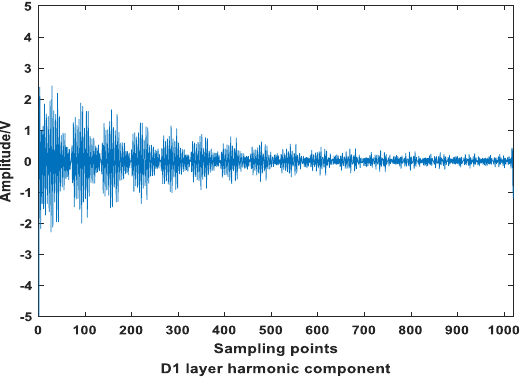
Figure-13. D2 layer reconstruction waveform compared with the original waveform.